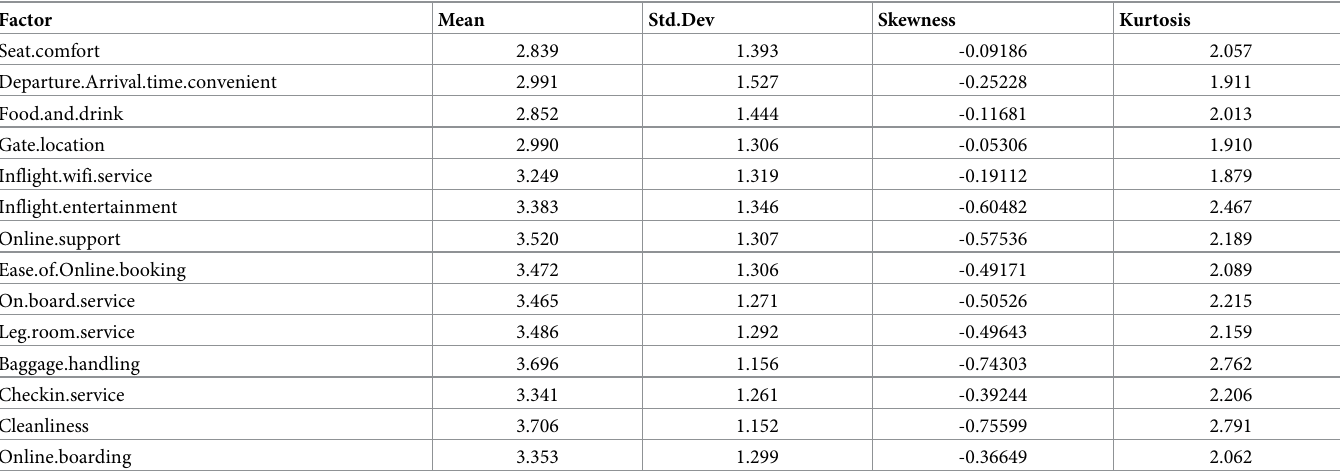
Table 5. Summary statistics for raw